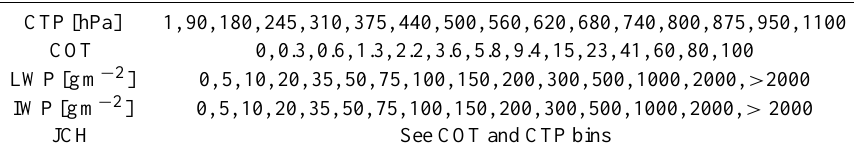
Fig. 5. Top panels show maps of relative occurrence of clouds with cloud optical thickness (COT) between 0 and 3.6 (a) and between 23 and 100 (b) . The values were normalized with the total number of clouds in each grid box. Panel (c) reports the histogram of COT aggregated over a central European region and (d) the equivalent for the maritime stratocumulus off the coast of Angola. Also shown are corresponding cumulative histograms (red). The regions are indicated in panel (a) . All data are for July 2010.